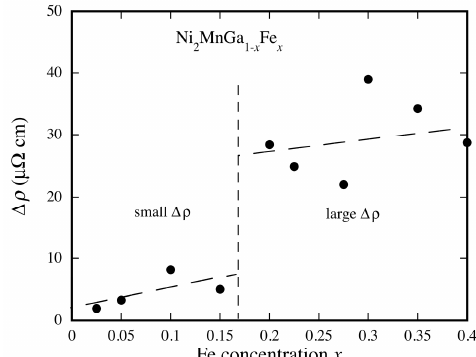
Figure 2. The concentration dependence of ∆ ρ for Ni 2 MnGa 1– x Fe x ( x = 0.025–0.40). The black dots are ∆ ρ obtained from the experimental data as shown in Figure 1, with dashed lines being guides to the eye. The vertical dotted lines distinguish the electric properties of Ni 2 MnGa 1– x Fe x to two regions.